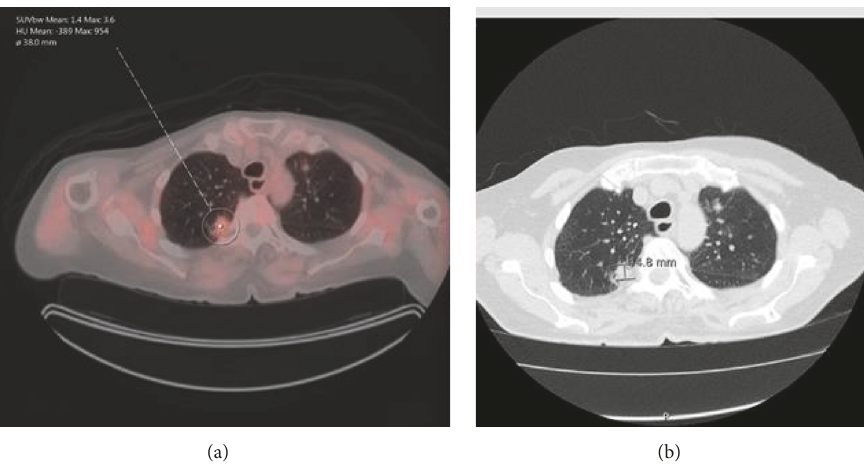
Figure 1: (a) On the left of the picture and (b) on the right of the picture. (a) PET CT showing increased uptake in the nodule. (b) CT Chest without contrast: 14.8 mm pleural-based mass-like density in the posterior medial right upper lobe.